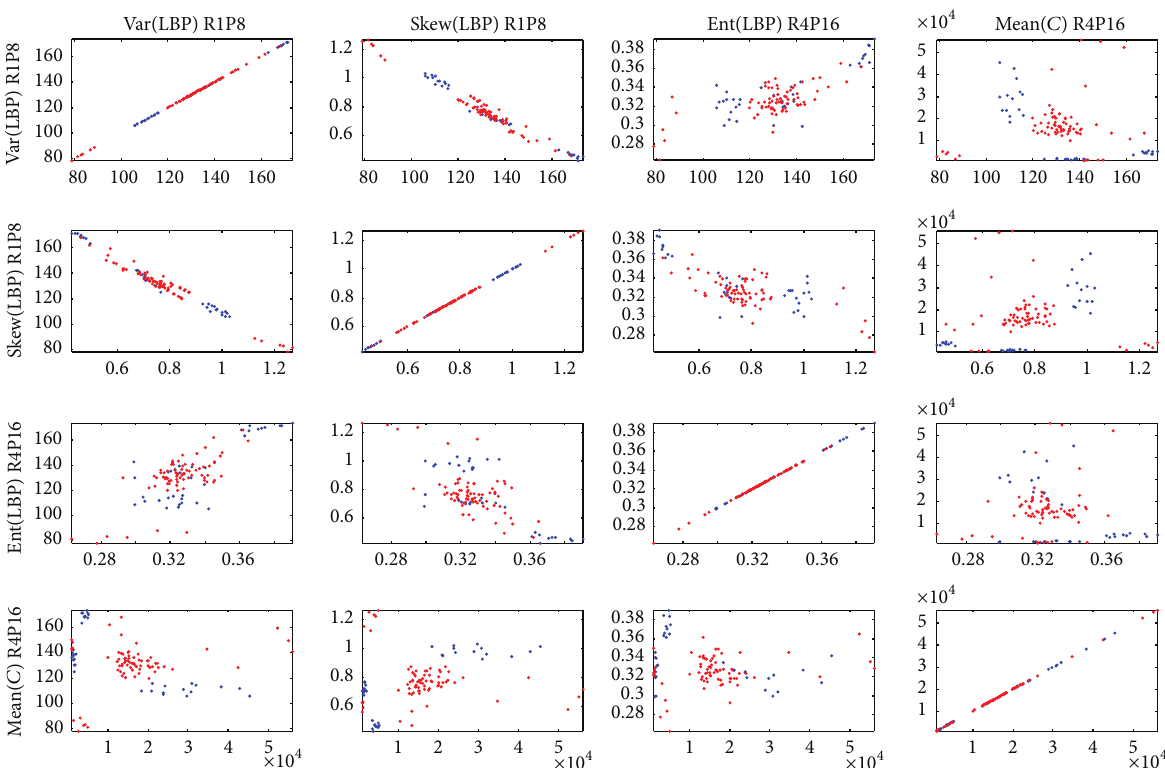
Figure 6: Matrix of scatter plots displaying the five selected features pairwise against each other. Blue depicts normal controls and red depicts dementia.